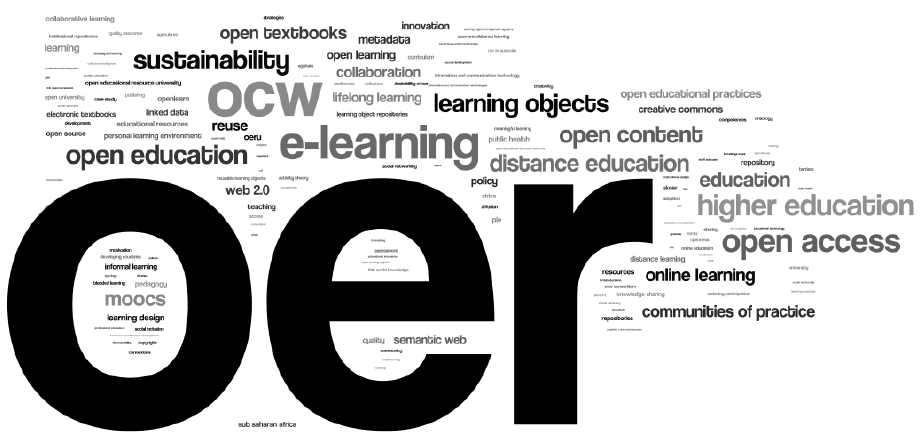
Figure 4. Cloud of